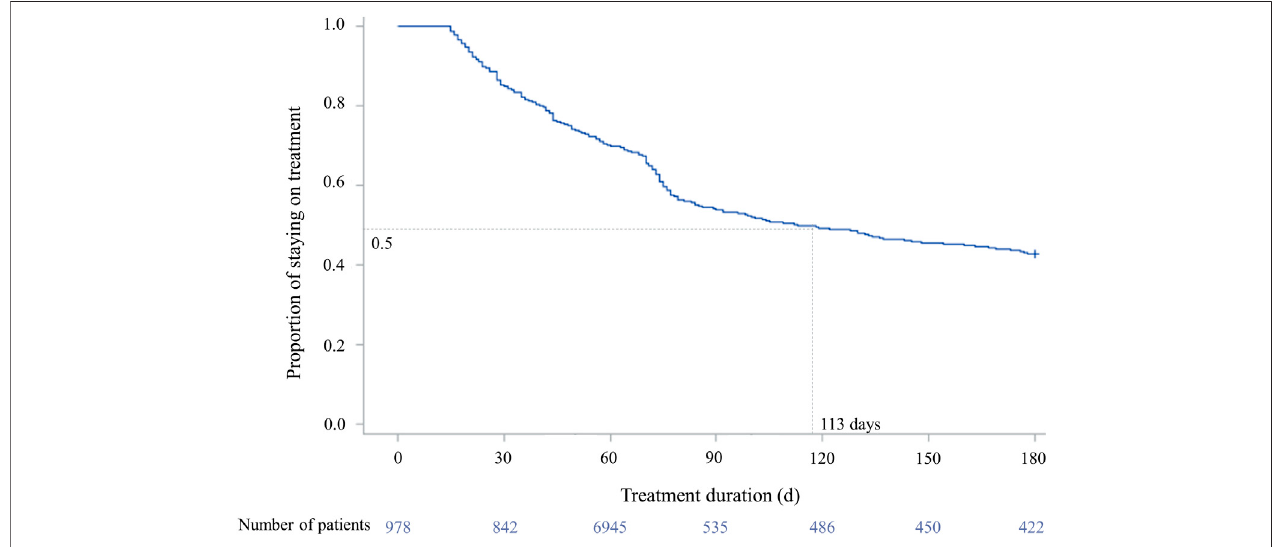
FIGURE 4 | Time-to-discontinuation of tuberculosis drug in study population. † Drug-susceptible tuberculosis treatment was de fi ned as discontinued if the prescription gap was over 14 days. ‡ The median time-to-discontinuation: 113 days (interquartile range 96 – 136). ¶ Log-rank test: p < 0.0001.